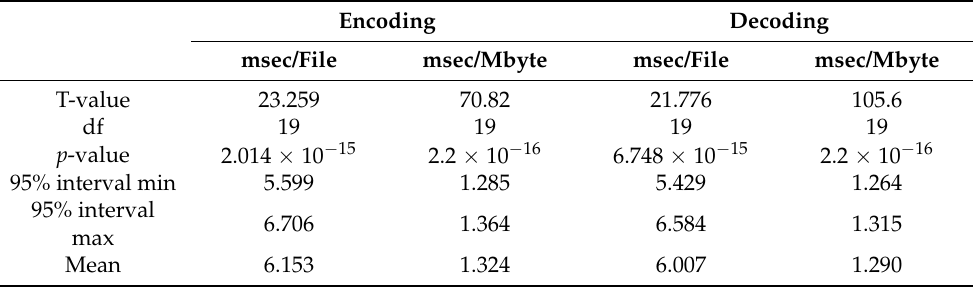
Table 12. One-sample T-test (R-Studio